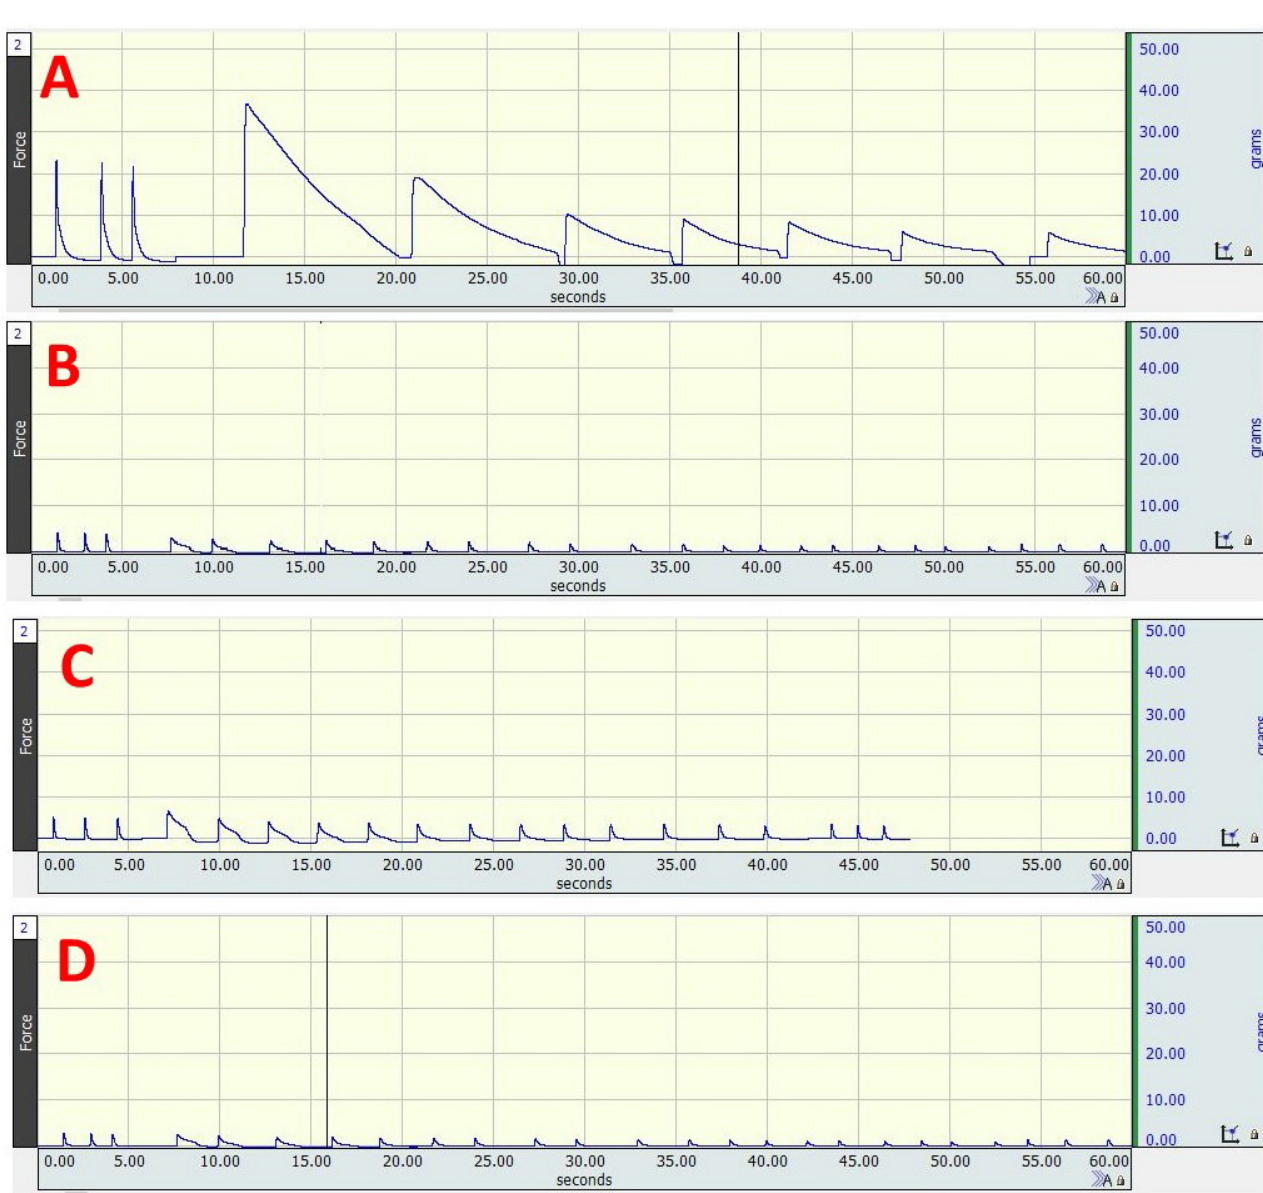
Figure 1. Isometric contractile properties of the soleus muscle in different experimental groups. ( A ) Control. ( B ) Dex. ( C ) Dex + H2S donor (NaHS). ( D ) Dex + H2S blocker (AOAA). Contractility re- cording was achieved by using Biopac Systems Inc. (BSL 3.7.5 software), (MP36) data analysis unit, Biopac force transducer assembly (SS12LA), Biopac BSLSTM stimulator, and needle electrodes (ELSTM2).